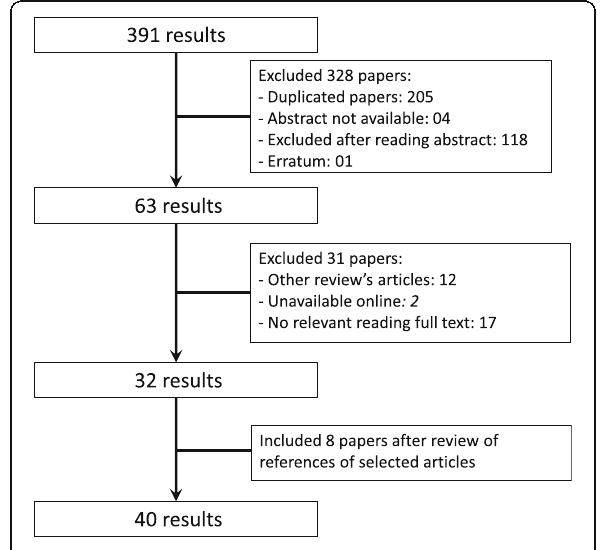
Fig. 1 Flowchart with the selection of articles for